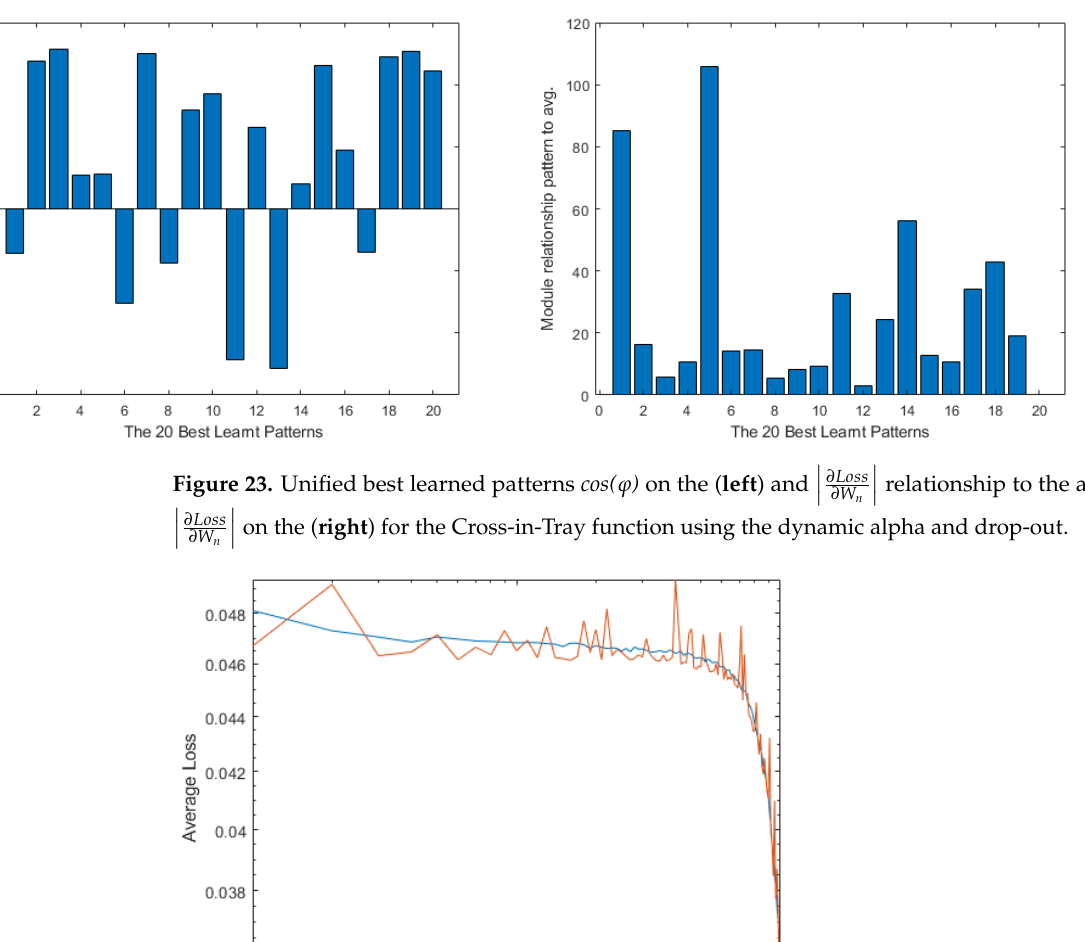
| relationship to the average 𝜕𝑊 𝑛